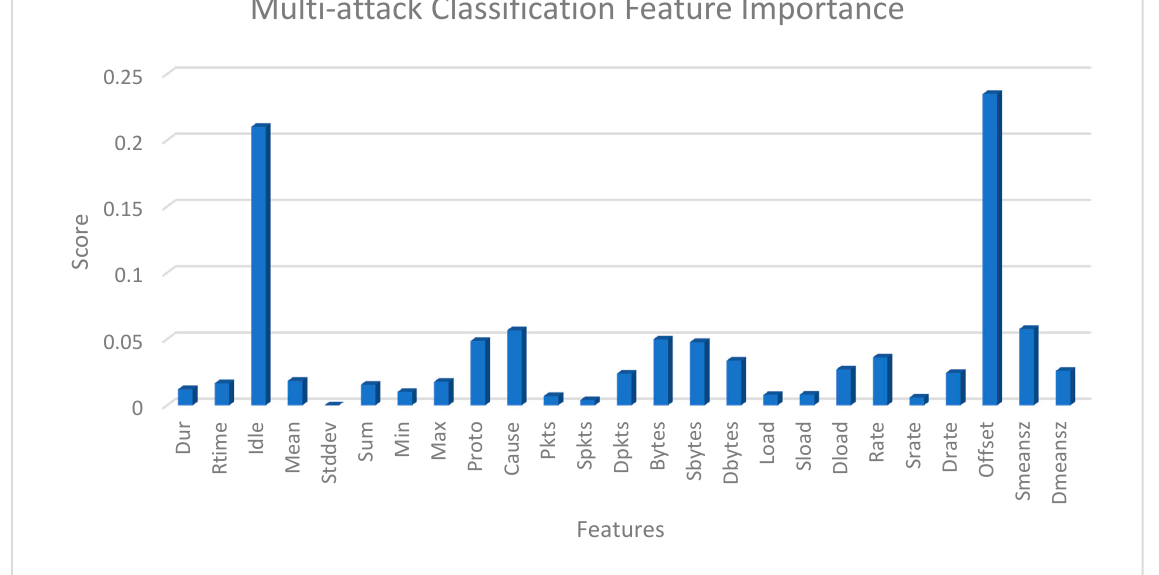
Figure 5. Feature importance for threat classification.